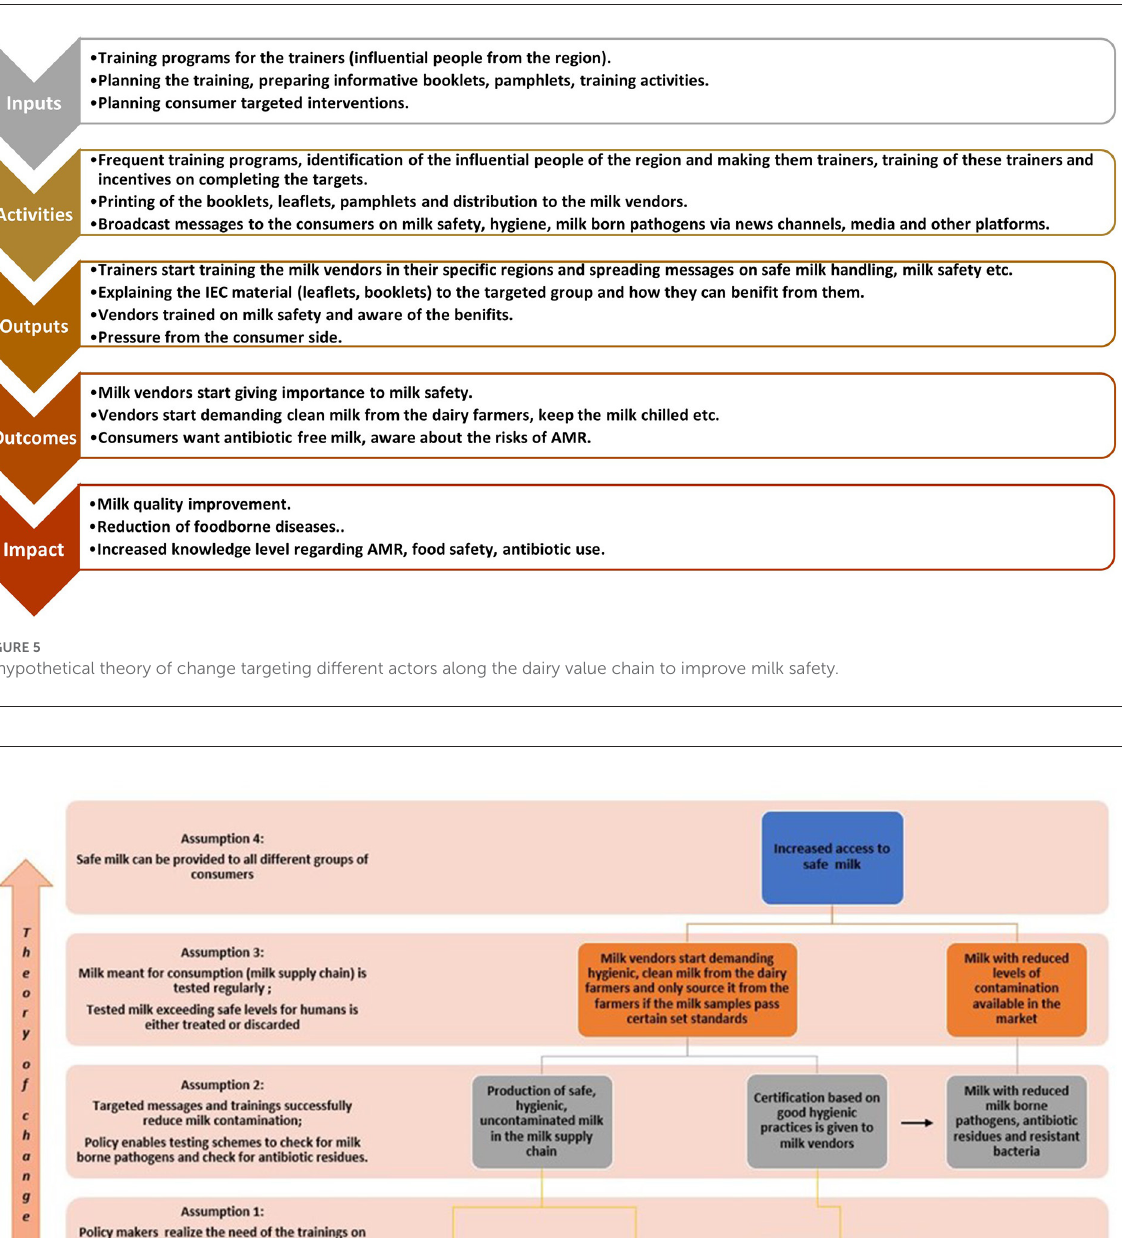
farmers in Haryana (Kumar and Gupta, 2018) revealed that the smallholder dairy farmers (7.14%) procured antibiotics from the milk vendors for the treatment of their animals. The fact